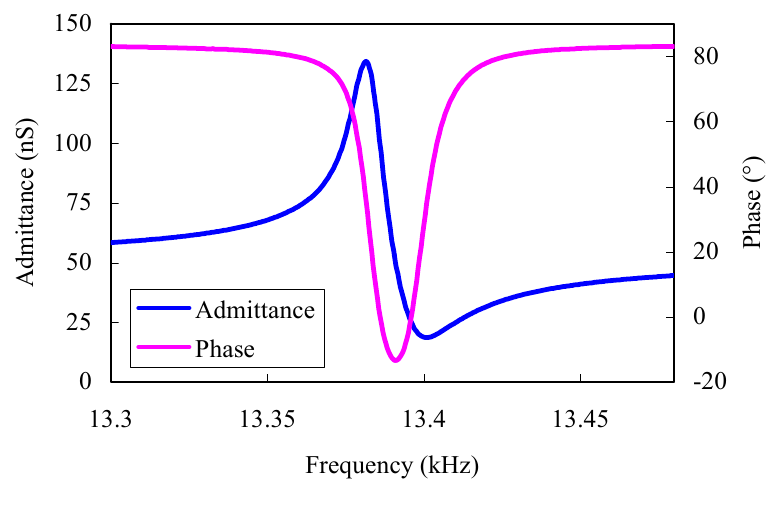
Figure 14. Admittance of drive mode.